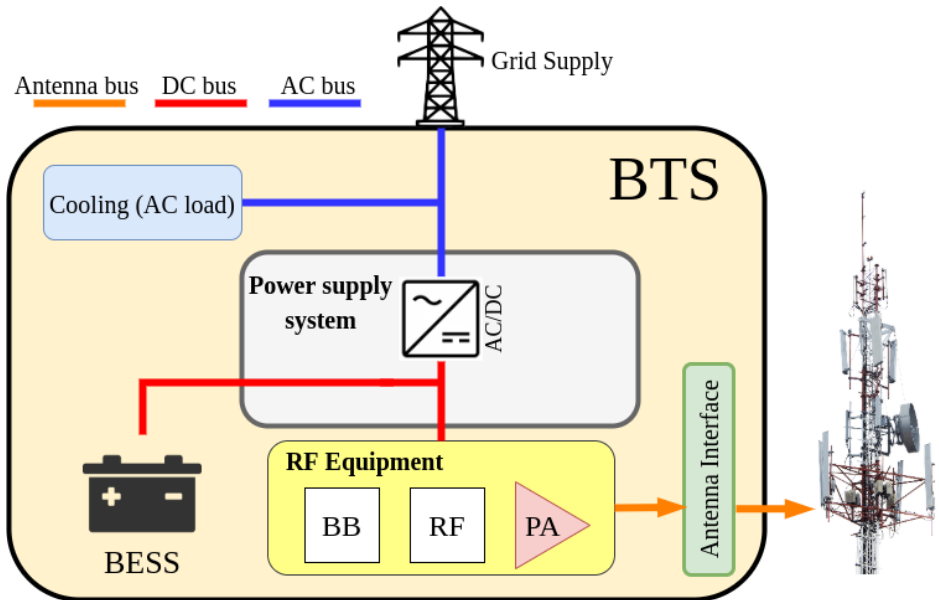
Figure 1. Conventional BTS architecture.